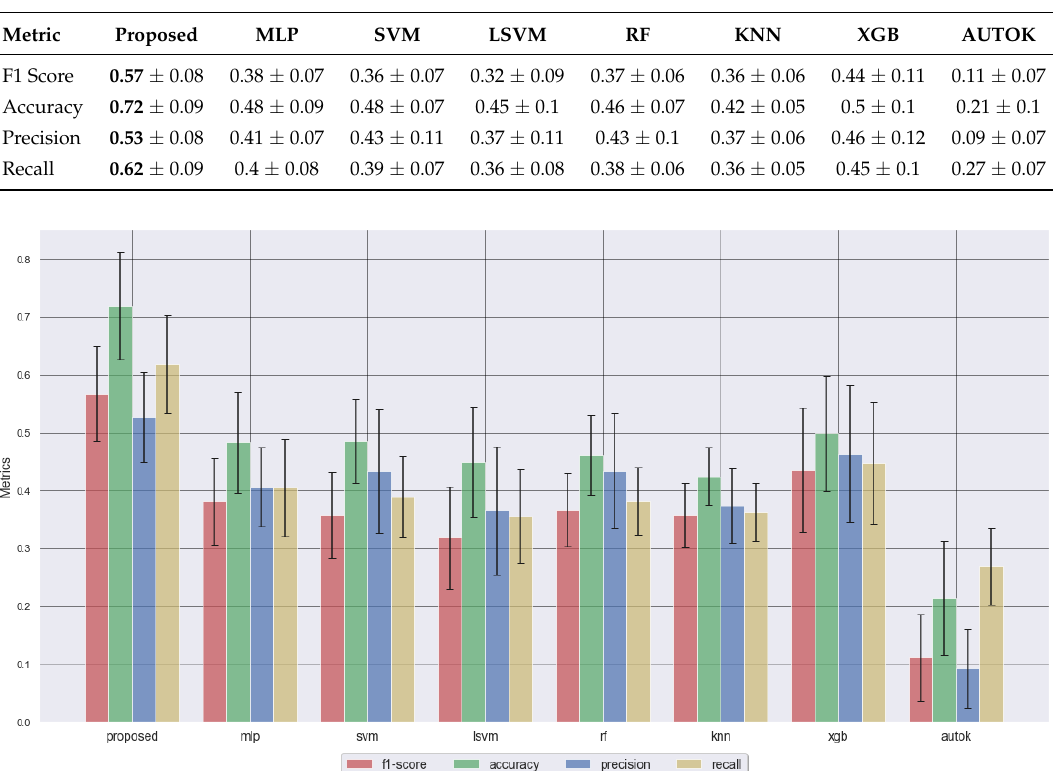
Figure 4. Results comparison of f-scores for the across-subject